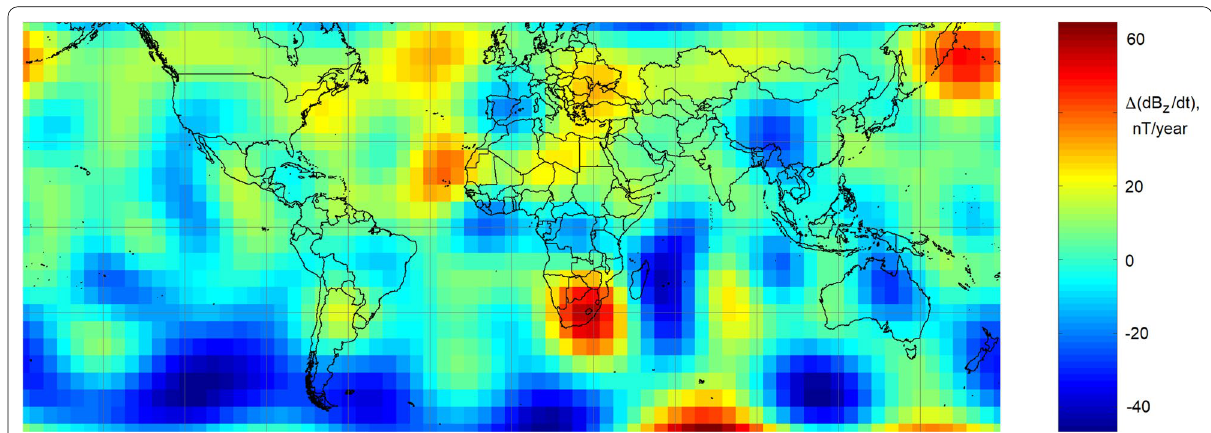
Fig. 9 Comparison of the SV (Z) derived from the N-1 and N-2 models over 1964–1970 with the SV (Z) according to the IGRF model over 1965– 1970. The map shows the SV (Z) differences calculated at the nodes of the regular geographic grid between 60 o N and 60 o S at a spherical surface with the mean Earth radius, 6371.2 km